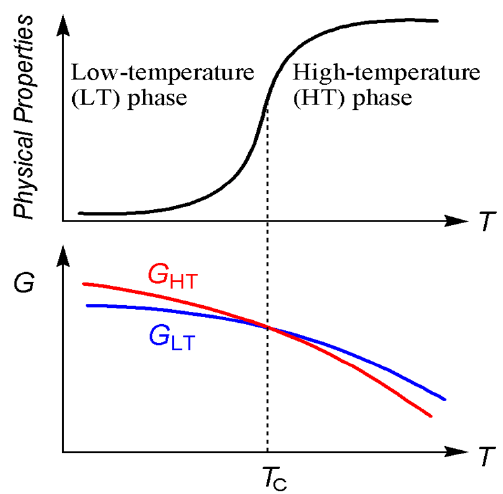
Figure 1. Schematic drawings of ( top ) physical properties (the product χ m T for example) as a function of temperature and ( bottom ) Gibbs energy diagram for phase transition materials.